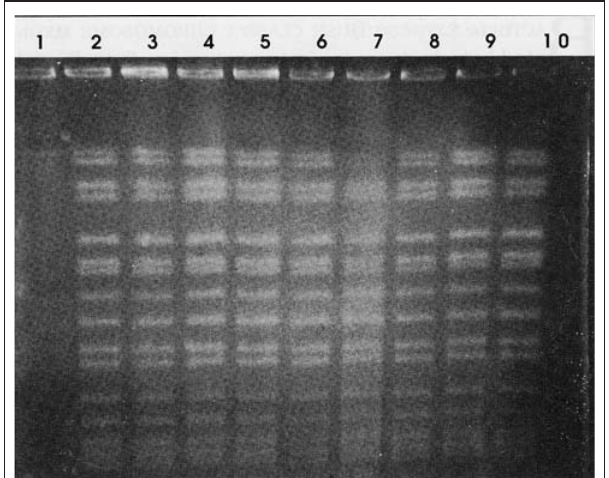
Figure 2) Xba I digested Enterobacter cloacae genomic DNA after pulsed field gel electrophoresis and ethidium bromide staining. Lane 1: blood isolate day 1; lanes 2 to 10: cerebrospinal fluid isolates from day 2 to 9. Identical banding is shown for all isolates, indicating a sin- gle